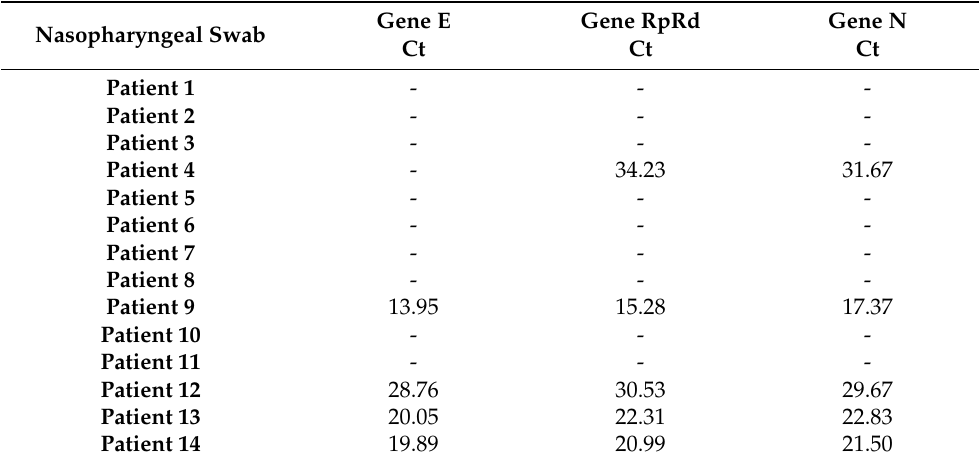
Table 3. Real-time, reverse trancriptase polymerase chain reaction results for severe acute respiratory virus-2 RNA on post-mortem nasopharyngeal